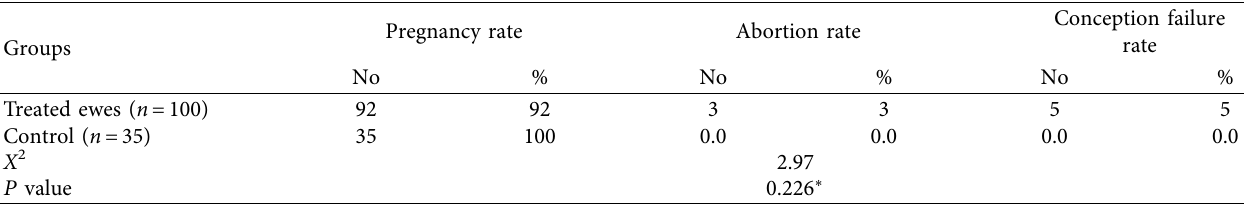
Table 1: Pregnancy, abortion, and pregnancy failure rates of Awassi ewes impregnated with intravaginal progestin sponges along with eCG and control group.